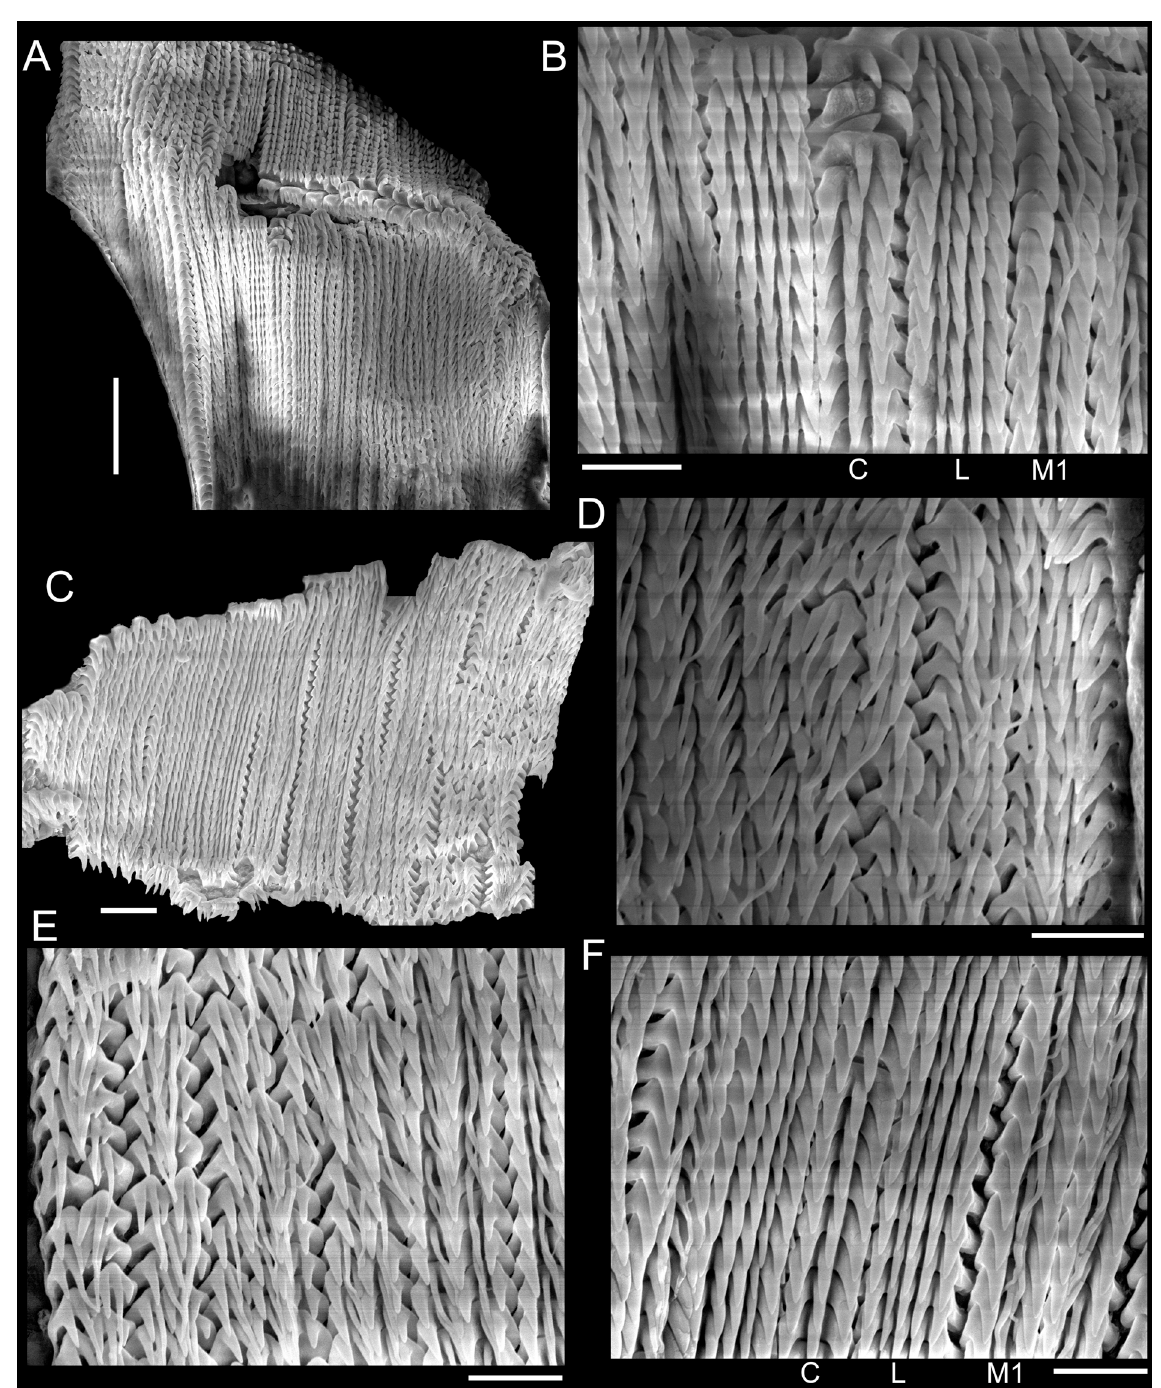
Fig. 22. Nototriphora decorata (C.B. Adams, 1850), radula. A–F . MNRJ 28854. Scale bars: A = 20 µm; B, D–F = 5 µm; C, 10